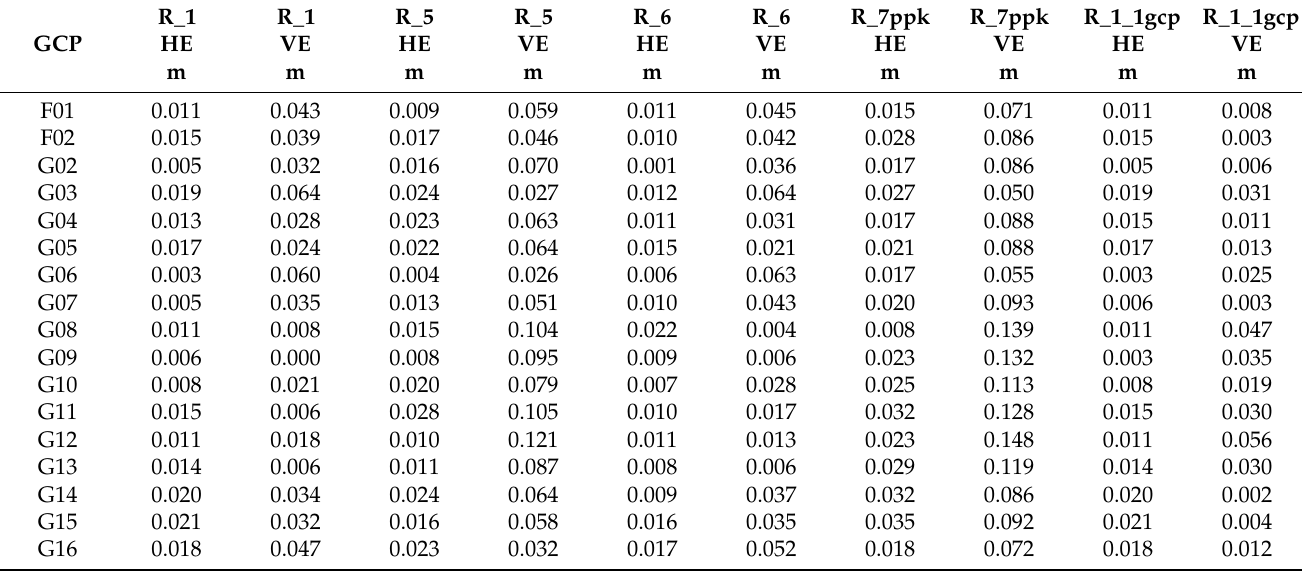
Table A1. Horizontal (HE) and vertical error (VE) on the 17 GCP positions in meters, of the R_1,